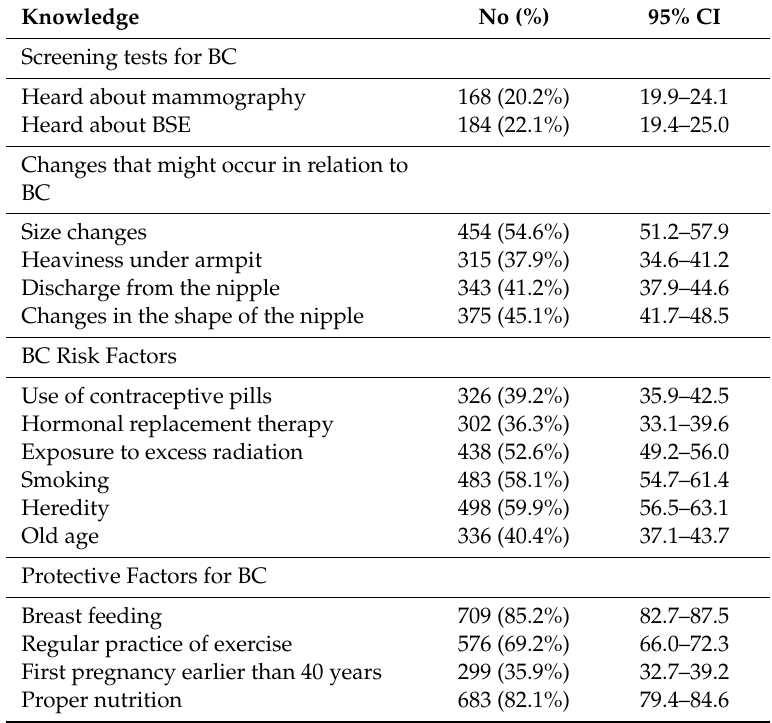
Table 2. Husbands’ knowledge about breast cancer (BC) and its associated risk and protective factors ( n = 832).